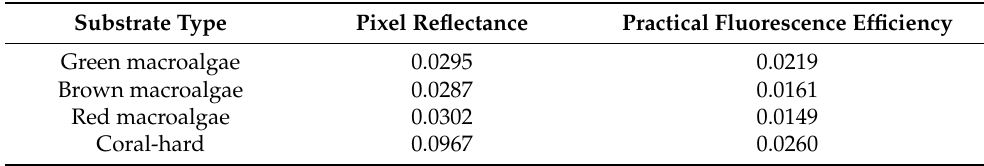
Table 1. Substrate reflectance and practical fluorescence yield values, corrected for water column attenuation